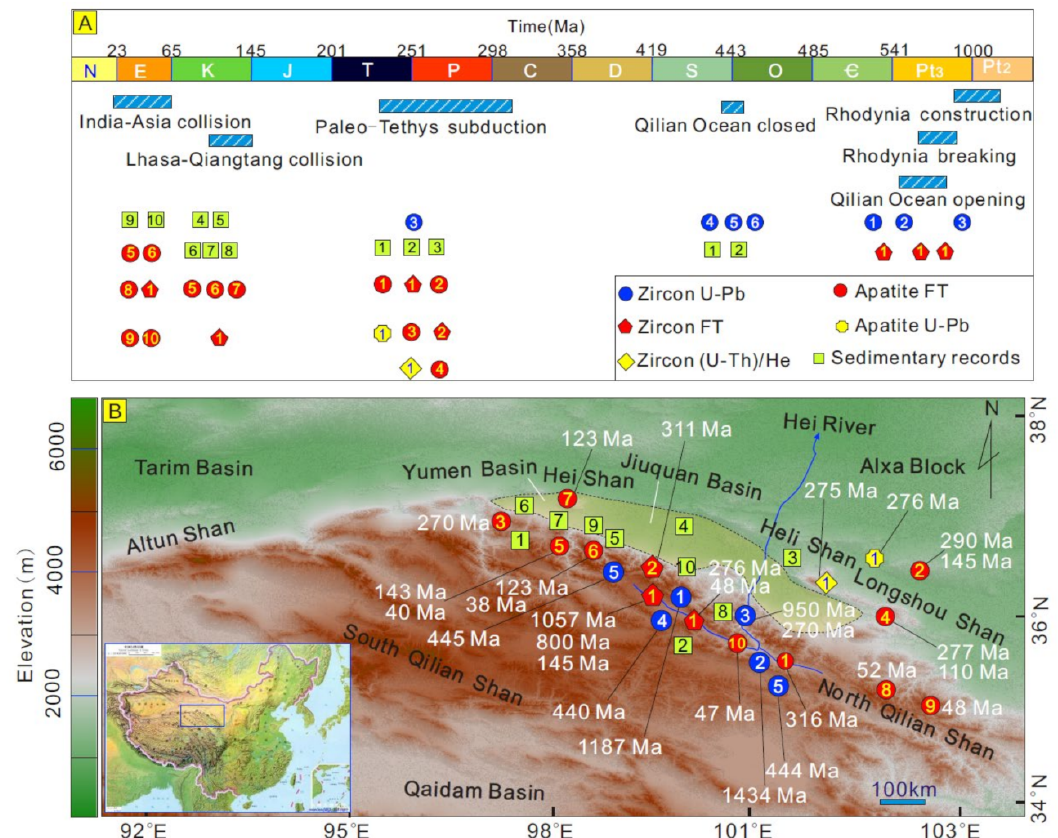
Figure 10. ( A ) Temporal distribution plot of tectonic-related events recorded in the North Qilian Shan, as constrained by zircon U-Pb, FT, and (U-Th)/He ages, apatite FT and U-Pb ages, and sedimentary records. ( B ) The specific distribution of the study sites in the North Qilian Shan, data source: zircon U-Pb ages, 1: [6]), 2: [36], 3: [90], 4: [107], 5: [7], 6: [32]; zircon FT ages, 1: This study, 2: [85];